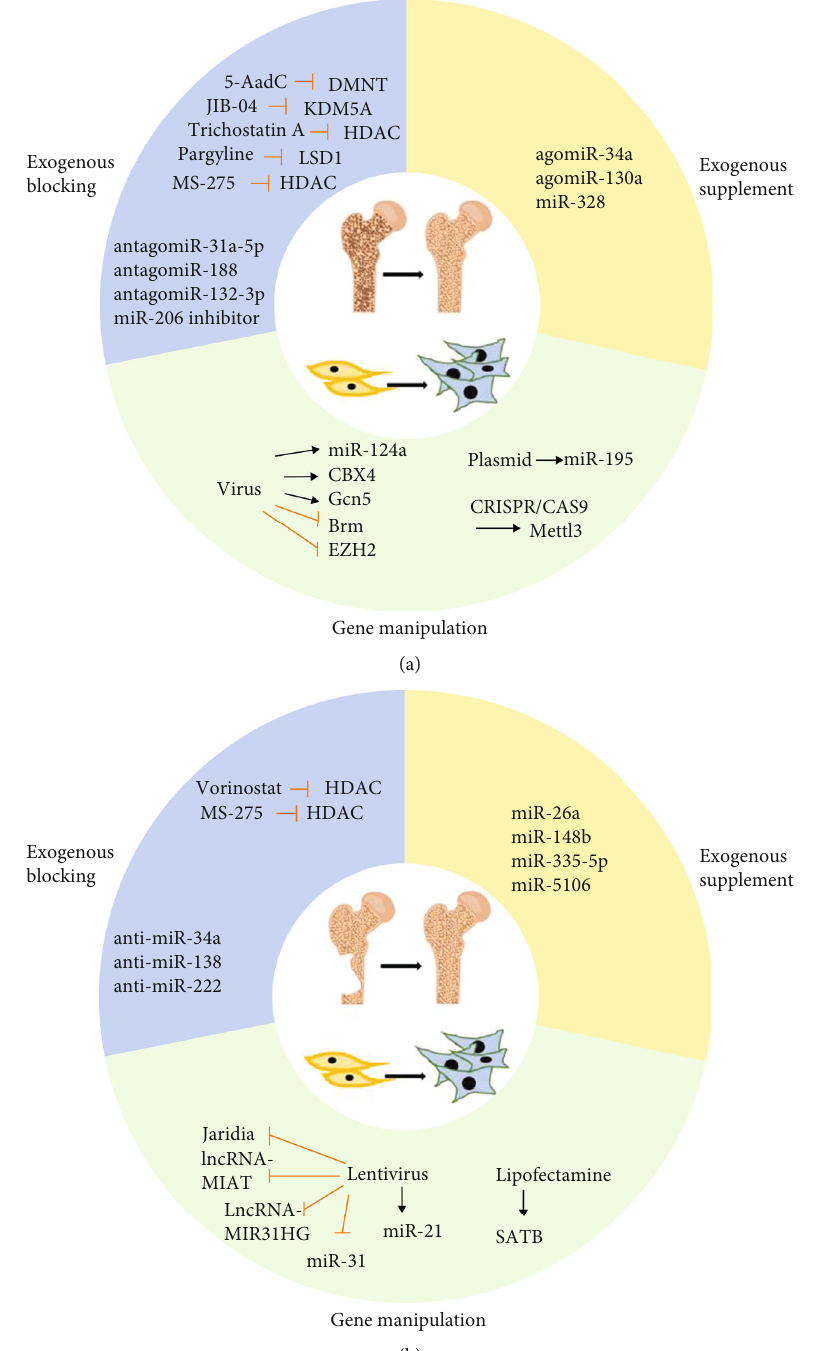
Figure 2: Application of epigenetic regulation in (a) skeletal diseases and (b) bone regeneration. Exogenous blocking or supplement and direct gene manipulation are separately used in both